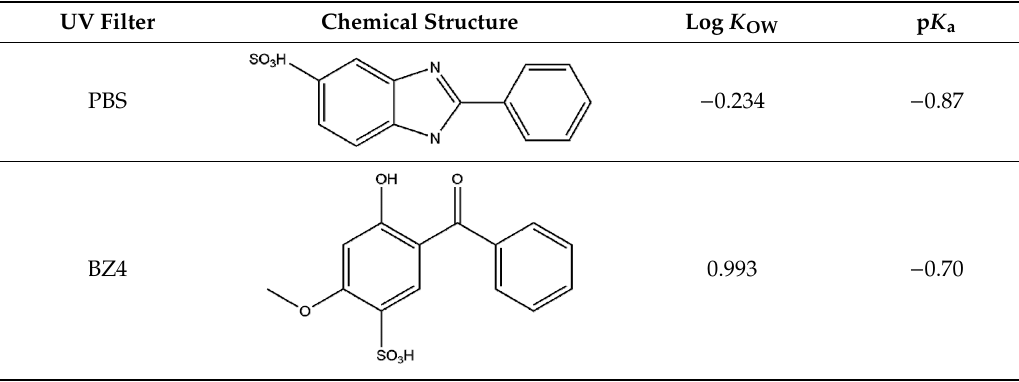
Table 1. Chemical structures, log K OW and p K a of the two ultraviolet (UV) filters under study. PBS: